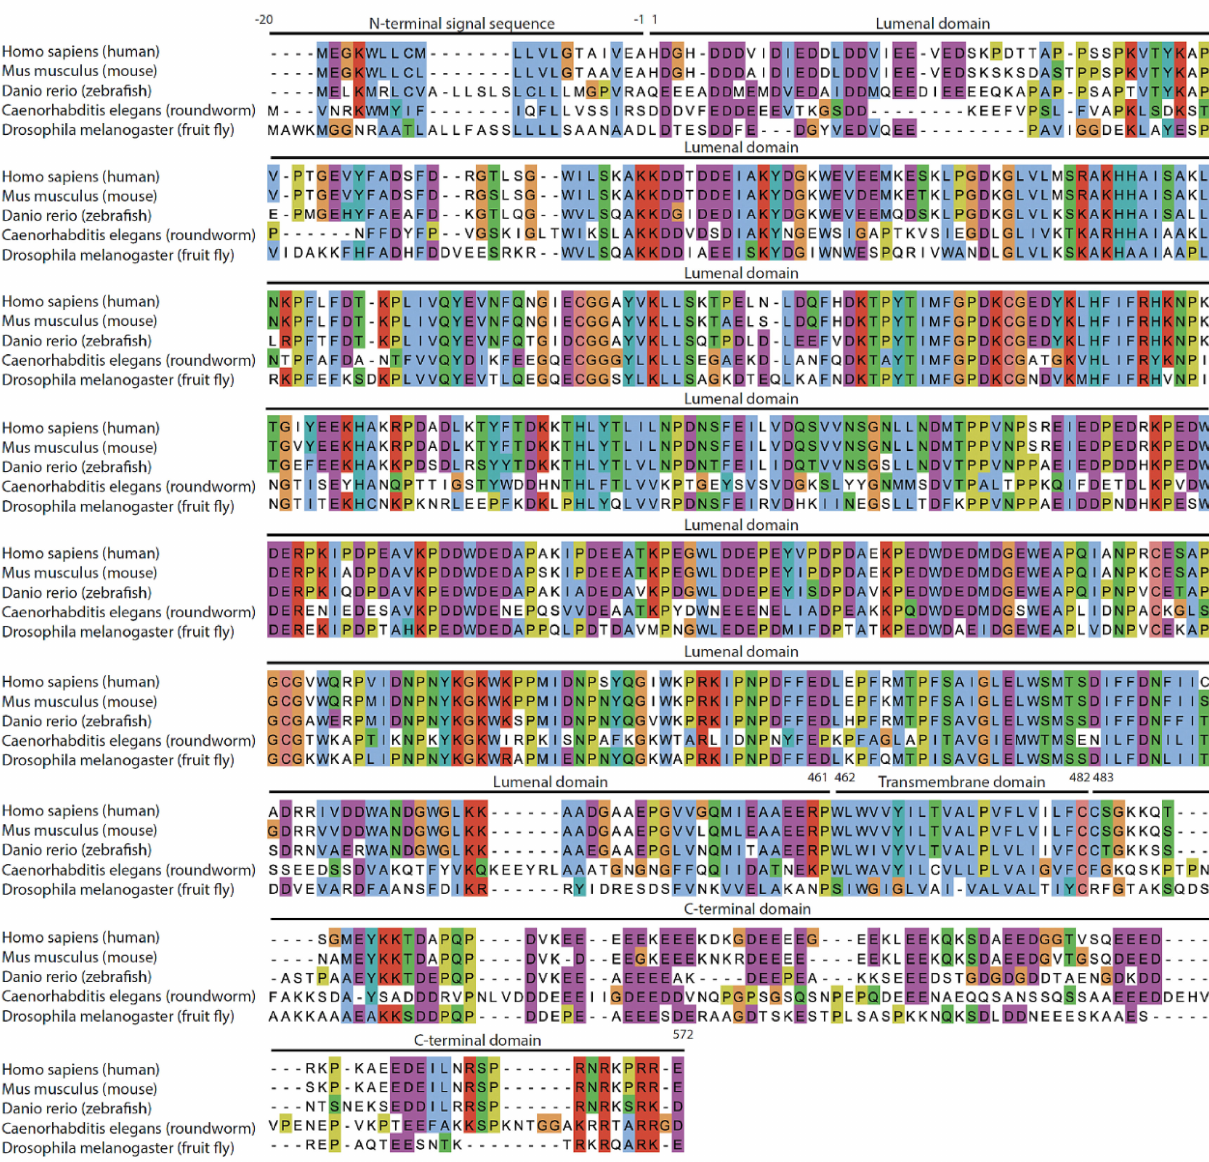
Figure 1. Amino acid sequence alignment of calnexin from different species. The default Clustal X color scheme was used for similar/identical amino acid residues [42]: blue for hydrophobic, red for positively charged, magenta for negatively charged, green for polar, cyan for aromatic, pink for cysteine, orange for glycine, yellow for proline and no color for amino acid residues that are not conserved. Dashes represent gaps in the amino acid sequence. The N-terminal signal sequence, intraluminal domain, transmembrane domain and C-terminal domain are indicated based on human calnexin protein topology. The numbering of amino acid residues referred to in the figure as well as the text corresponds to the mature human calnexin protein. Alignment was performed using Multiple Alignment using Fast Fourier Transform (MAFFT) high speed multiple sequence alignment program (https://toolkit.tuebingen.mpg.de/tools/mafft; accessed 31 August 2022). Jalview [43] was used to visualize amino acid alignment. Additional calnexin sequences from different species are shown in Supplementary Figure